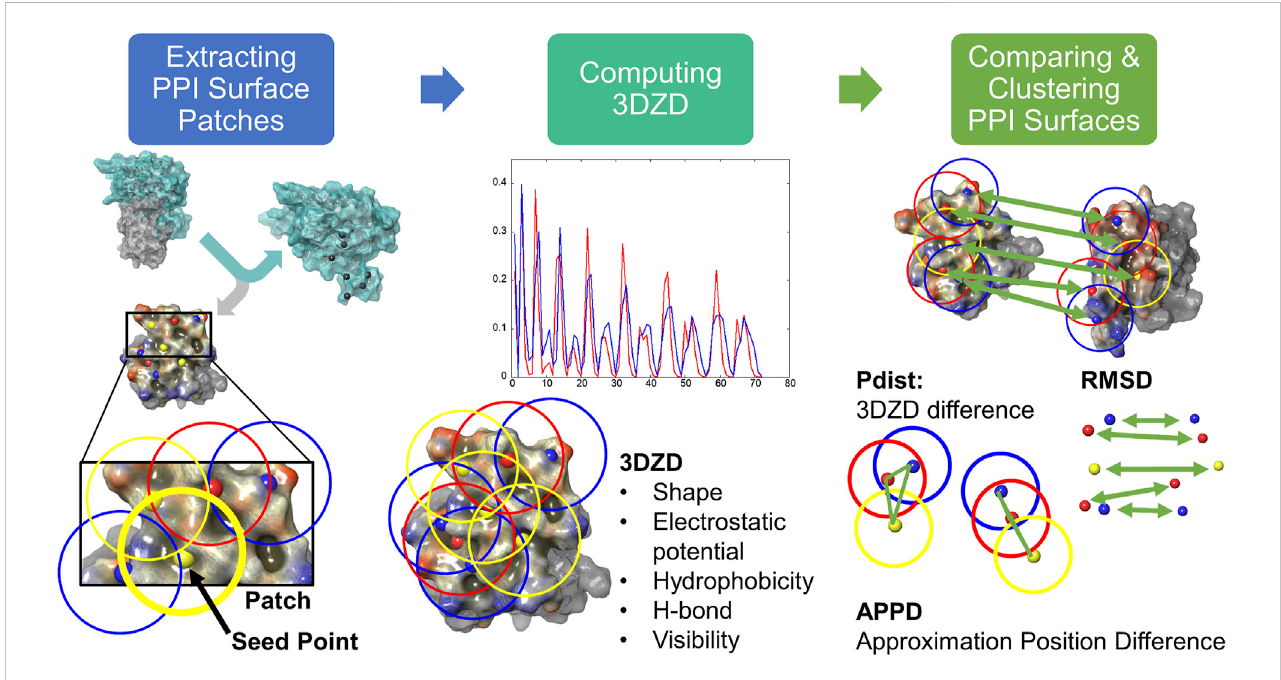
FIGURE 1 Work fl ow of